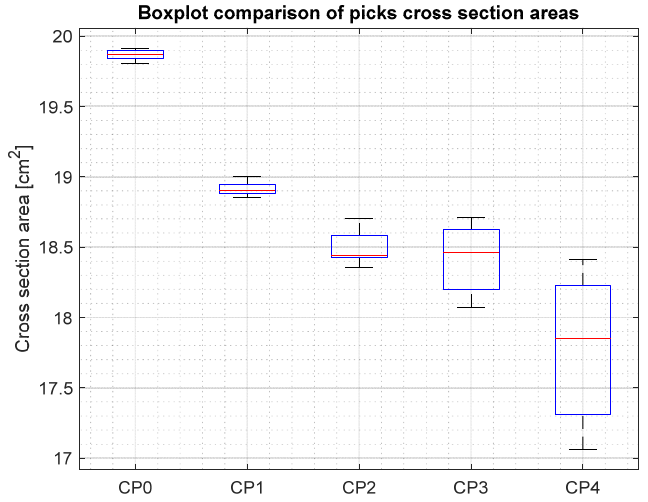
Figure 11. Cross-section areas of Figure 11. Cross ‐ section areas of picks. As expected, the CP0, being the reference specimen, has low deviation and the highest average cross ‐ section value. The eccentrically placed mean value (red line) in the CP2, CP3 and CP4 provides information about the asymmetrical wear of the picks. The bigger the box, the bigger the value of asymmetry.